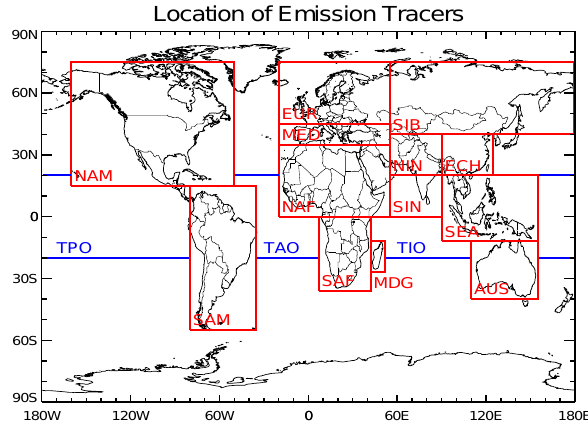
Figure 1. Global geographical location of artificial boundary layer source regions in the CLaMS model, also referred to as “emission tracers” (Vogel et al., 2015). The latitude and longitude range for each emission tracer is listed in Table 1.